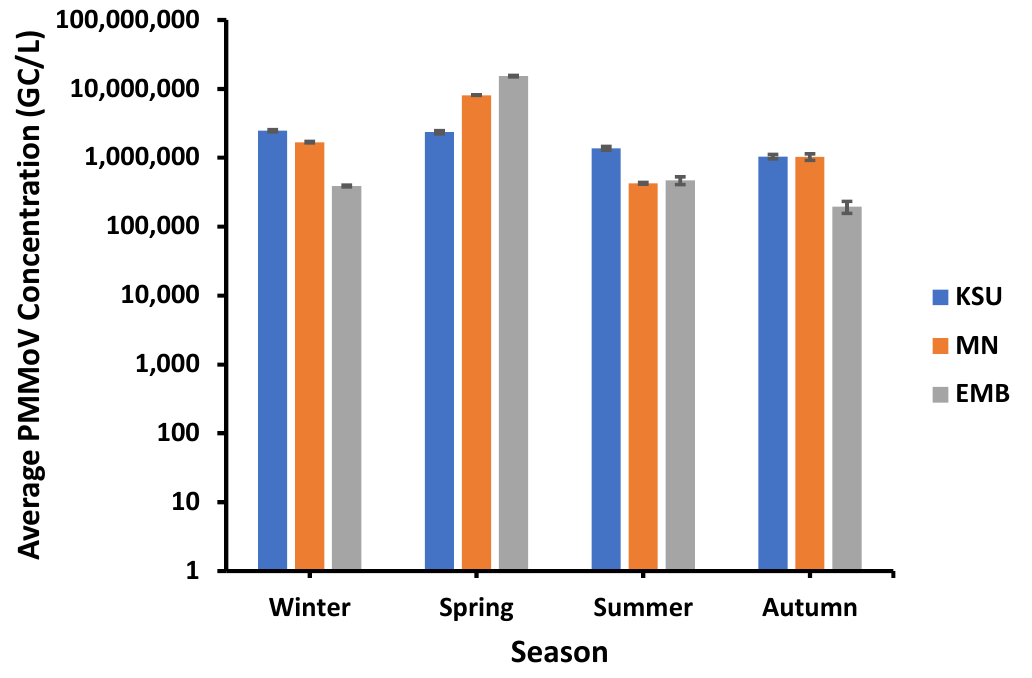
The highest PMMoV concentrations (6.22 × 10 6 , 1.51 × 10 7 , and 3.55 × 10 7 GC/L) gen- erally occurred in mid-winter and early spring at low temperatures (high: 26 °C–30 °C, low: 10 °C–20 °C), particularly in January and March at KSU-WWTP, MN-WWTP, and detected at higher temperatures (high: 34 °C and 44 °C, low: 18 °C and 30 °C) at EMB- centration at MN-WWTP was found at lower temperatures (high: 26 °C, low: 12 °C). De- insignificant influence on the prevalence of PMMoV ( p > 0.05) at EMB-, MN-, and KSU- WWTPs (T H : R 2 = 0.04, 0.043, and 0.02, respectively, and T L : R 2 = 0.0005, 0.014, and 0.021, respectively; Table 2). Table 2. Significance of environmental factors’ influences on the concentration of PMMoV.